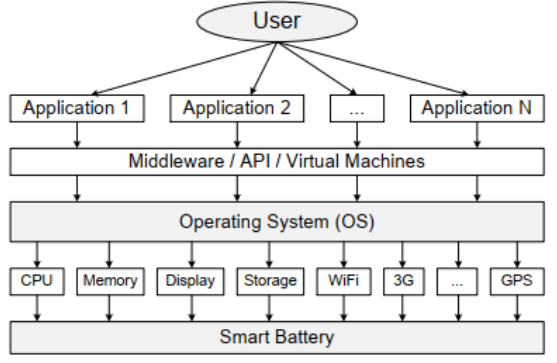
Figure 1. Example of a process-oriented breakdown of energy use in a smartphone